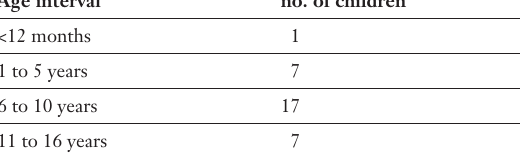
Main diagnostic cate- gories of children re- quiring home ventila- tion in